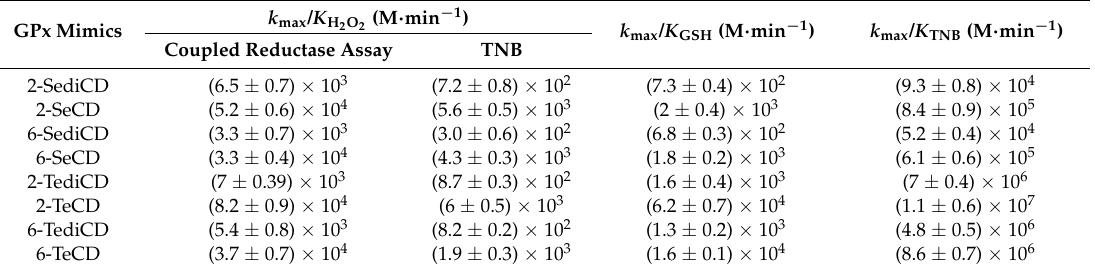
Table 2. Enzyme kinetic parameters were measured by coupled reductase assay and TNB.